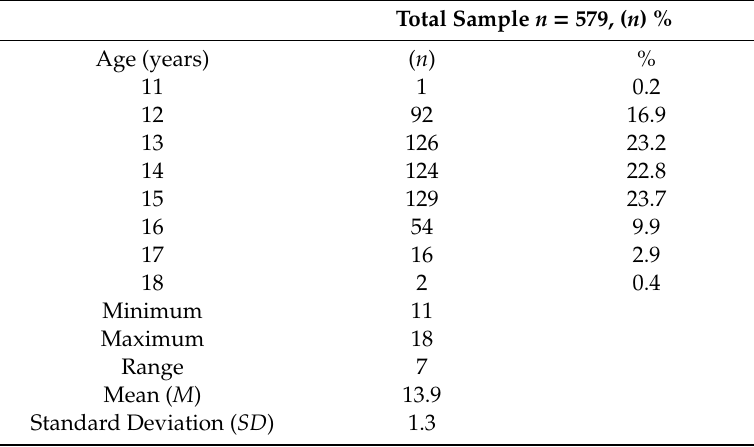
Table 1. Participants’ age range